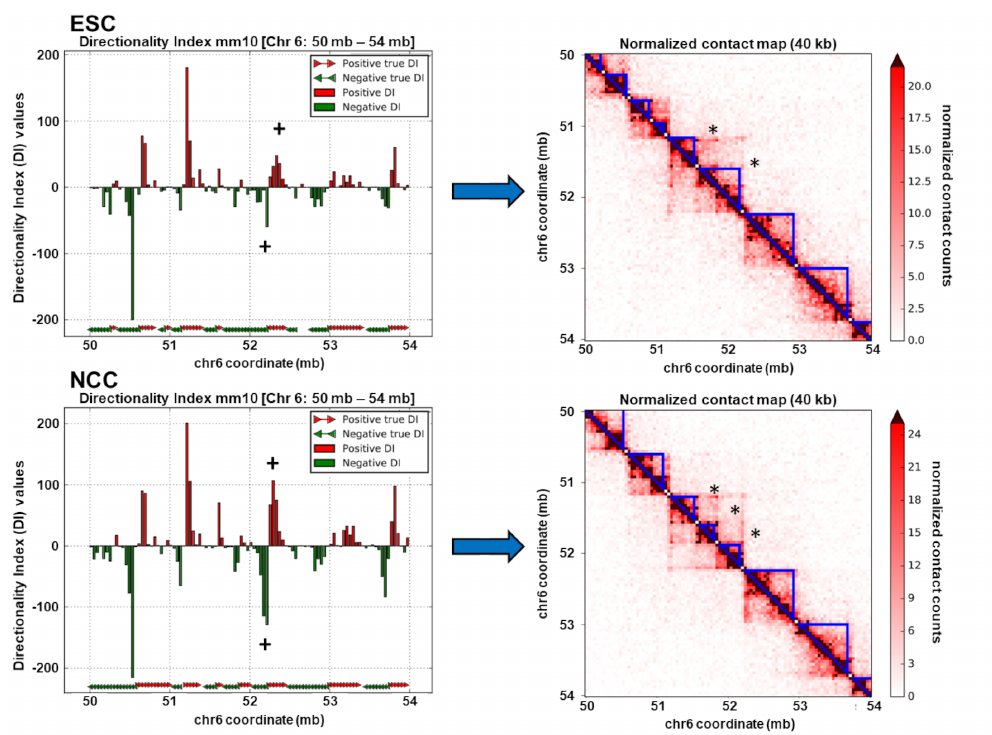
Figure 3. TADs occur in both ESC and NCC. ESC and NCC chr6 50–54 directionality indexes ( left ) and calculated TADs ( right ), with an example of directionality index (+) and TAD (*) reorganization during NCC